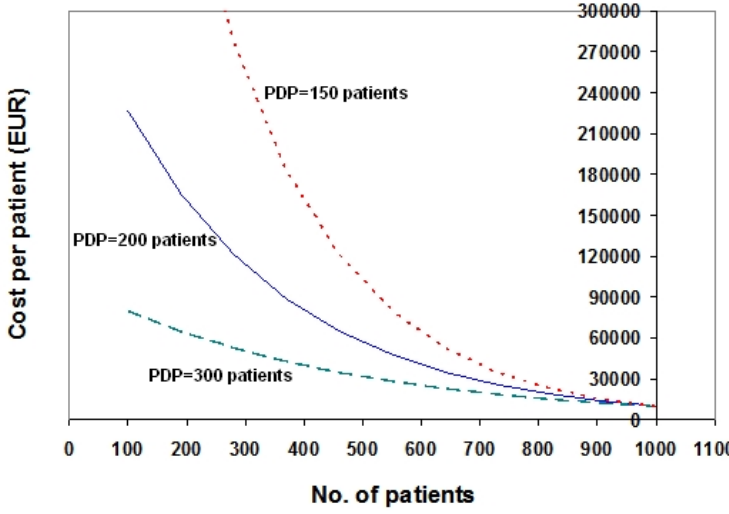
Figure 1. Price-vs.-patients relationship for orphan drugs. The graph shows three different exponential models that assume price-doubling population (PDP) = 150 patients (dotted line in red), 200 patients (solid line in blue), and 300 patients (dashed line in green), respectively. Other assumptions: full price (fPRICE) = 10,000 EUR.